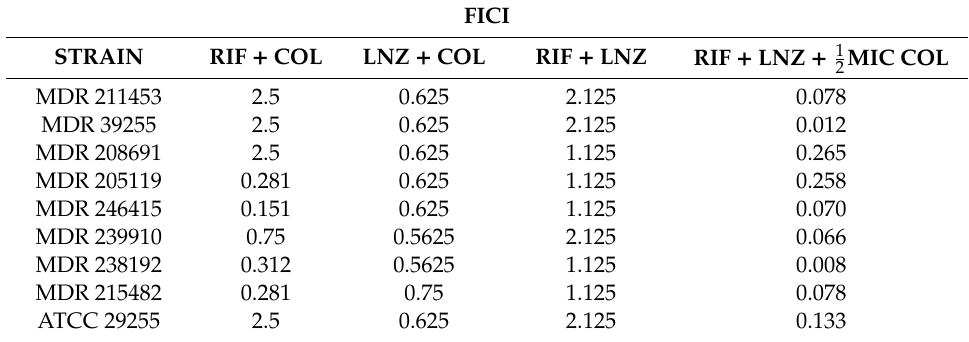
Table 2. Checkerboards of the di ff erent antibiotics used with their fractional inhibitory concentration indexes (FICIs) in multidrug-resistant (MDR) E. coli